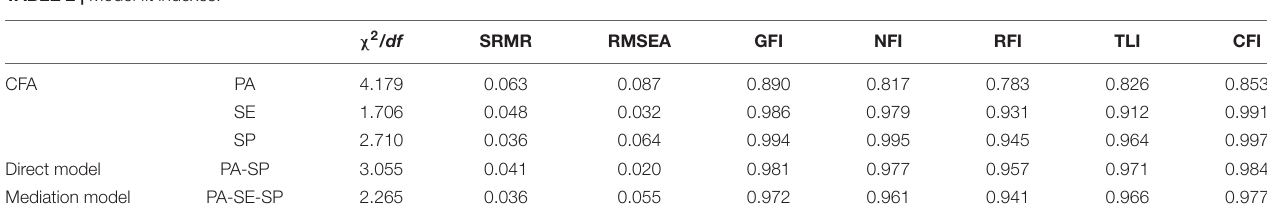
TABLE 2 | Model fit indexes.